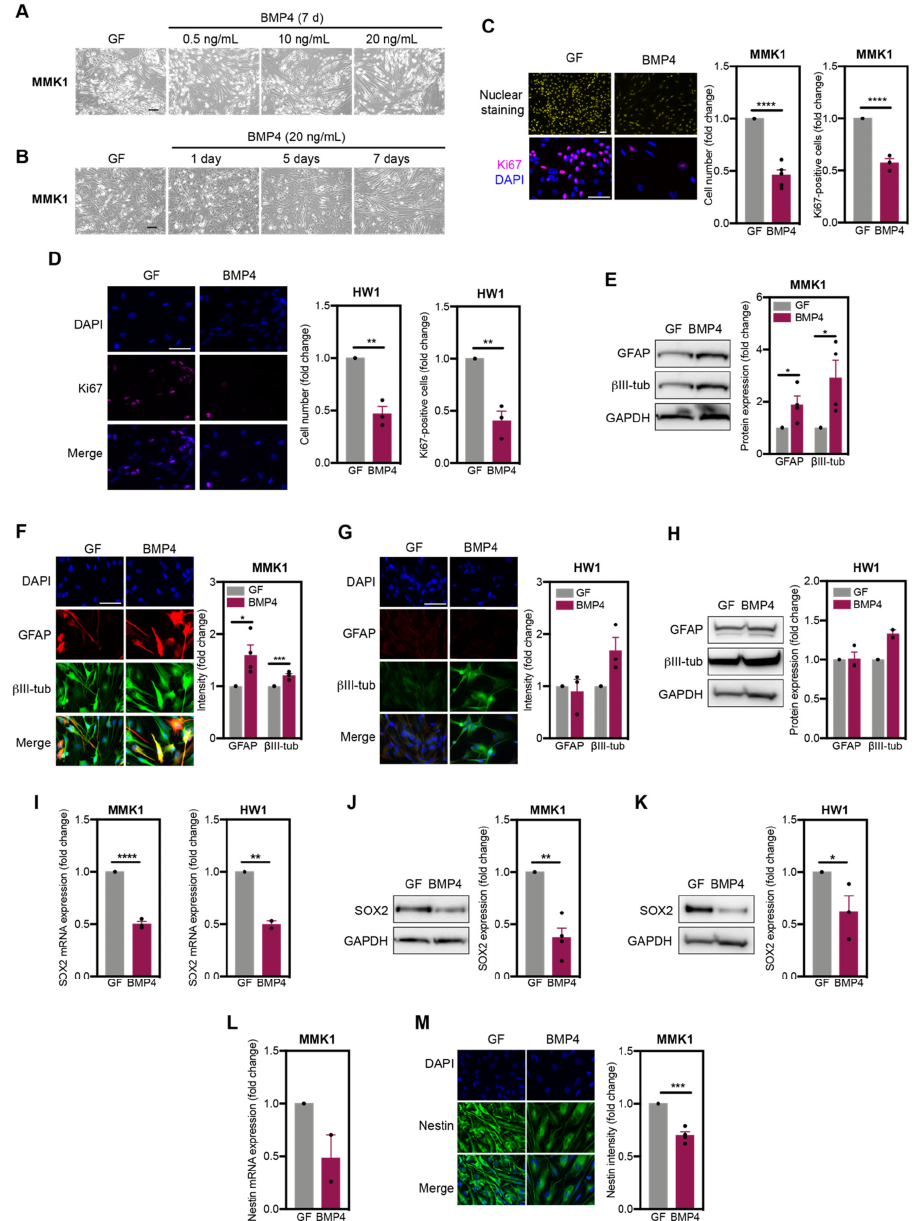
Figure 1. BMP4 induces differentiation in glioblastoma stem cells. ( A , B ) Microscopy images of MMK1 cells cultured with growth factors (GF) or bone-morphogenetic protein 4 (BMP4). Scale bar: 10 μ m. For all remaining figure panels, MMK1 and HW1 cells were cultured with GF to maintain their stem-like phenotype. To induce differentiation, GF were replaced with BMP4 (20 ng/mL, 7 days). ( C , D ) Nuclear staining and Ki67 immunofluorescence images with quantifications of MMK1 ( C ) and HW1 ( D ) cells cultured with GF or BMP4. DAPI was used to visualise cell nuclei (blue). Scale bar: 10 μ m. ( n = 3–5). ( E , F ) Immunofluorescence ( E ) and immunoblot ( F ) images with quantification of GFAP and β III-tubulin ( β III-tub) in MMK1 cells cultured with GF or BMP4 ( n = 3–4). Scale bar: 10 μ m. ( G , H ) Immunofluorescence ( G ) and immunoblot ( H ) images and quantification of GFAP and β III-tubulin ( β III-tub) in HW1 cells cultured with GF or BMP4 ( n = 3–4). Scale bar: 10 µ m. ( I ) RT-PCR analysis of SOX2 mRNA in MMK1 and HW1 cells cultured with GF or BMP4 ( n = 2). ( J , K ) Immunoblot images and quantification of SOX2 expression in MMK1 ( J ) and HW1 ( K ) cells cultured with GF or BMP4 ( n = 3–4). ( L ) RT-PCR analysis of nestin mRNA in MMK1 cells cultured with GF or BMP4 ( n = 2). ( M ) Immunofluorescence images and quantification of nestin in MMK1 cells cultured with GF or BMP4 ( n = 4). All bar graphs represent mean ± SEM (two-tailed, unpaired t -test, * p < 0.05, ** p < 0.01, *** p < 0.001, **** p <